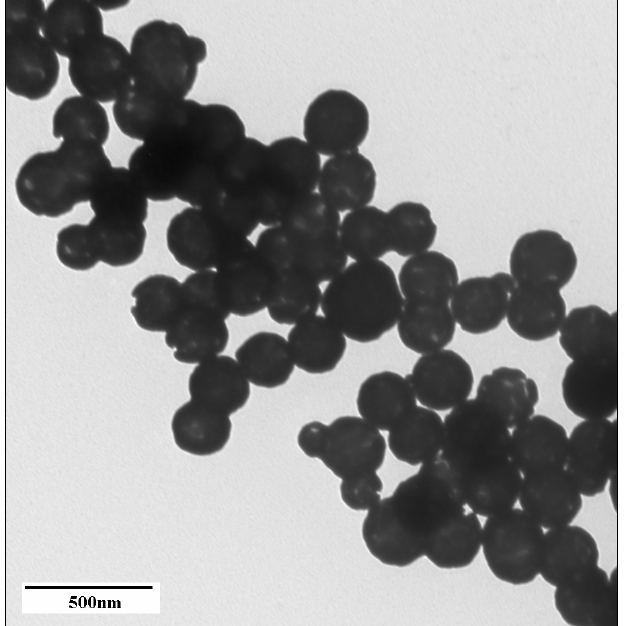
Figure 5. TEM image of Auroshell®